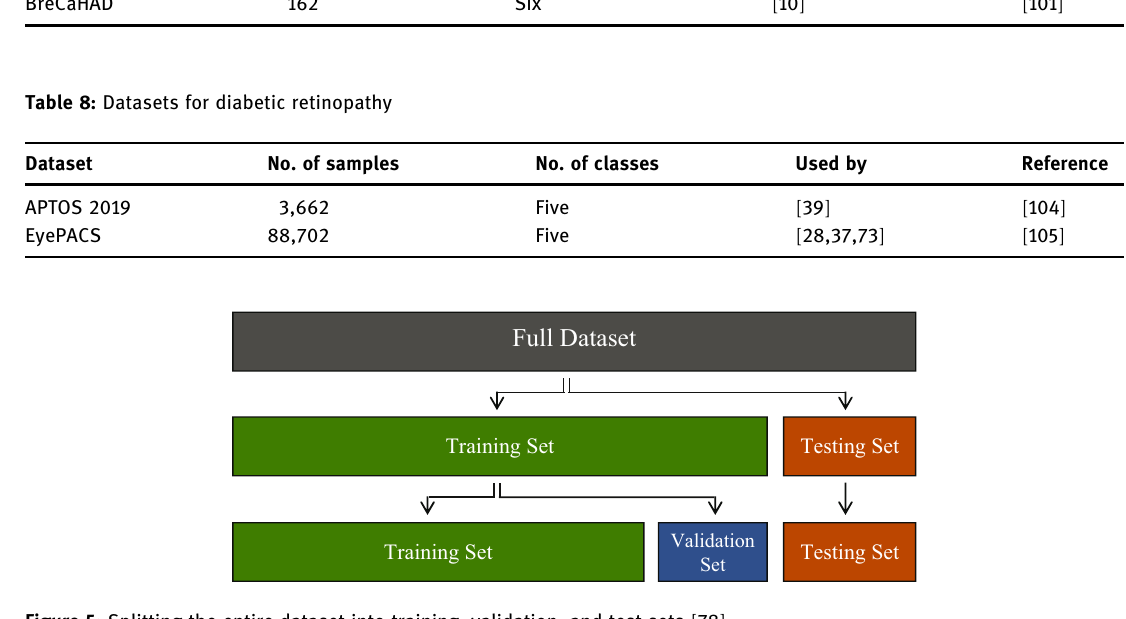
Figure 5: Splitting the entire dataset into training, validation, and test sets [ 78 ]